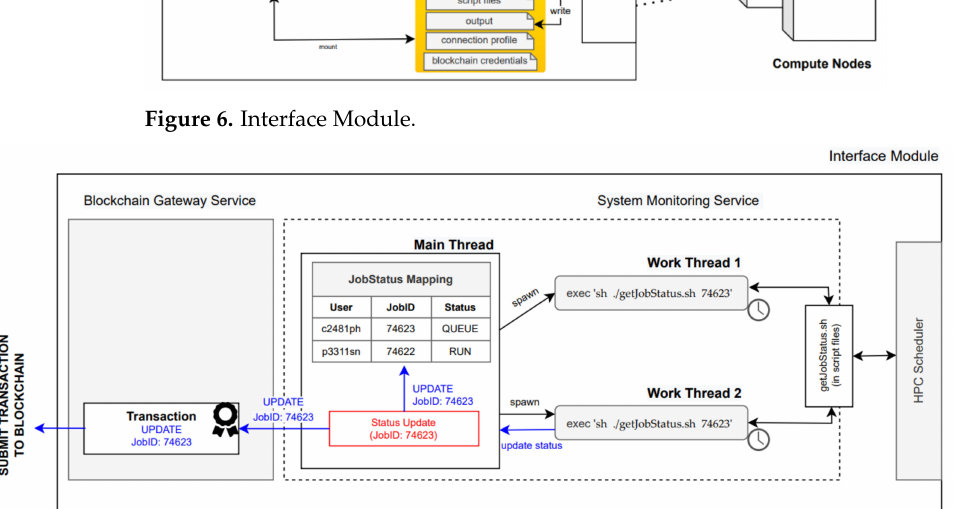
Figure 7. Job Monitoring Operation in Interface